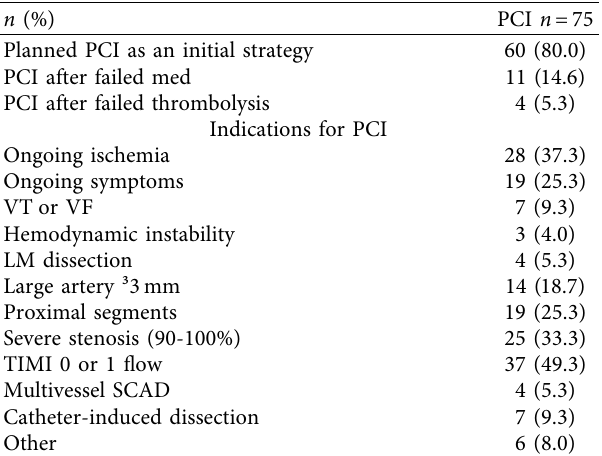
Table 3: Rationale for